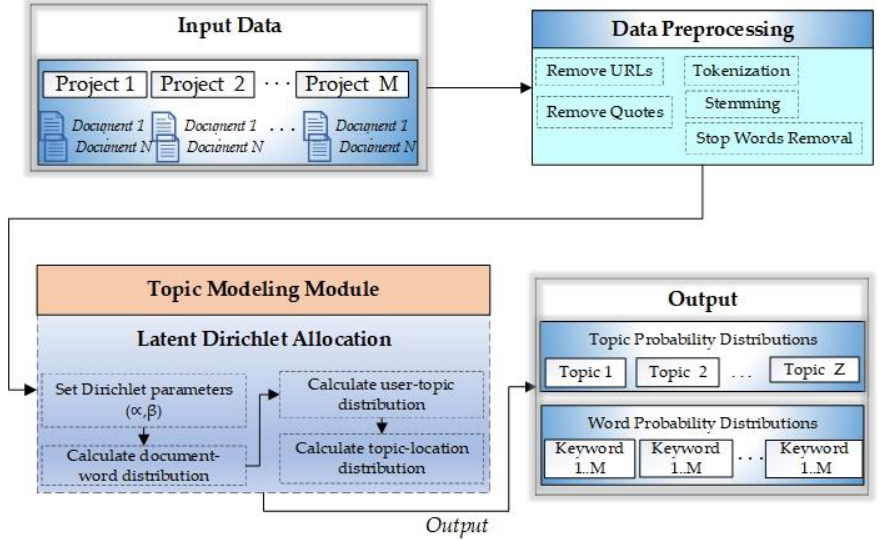
Figure 2. Latent Dirichlet allocation (LDA) Figure 2. latent Dirichlet allocation (LDA) process.